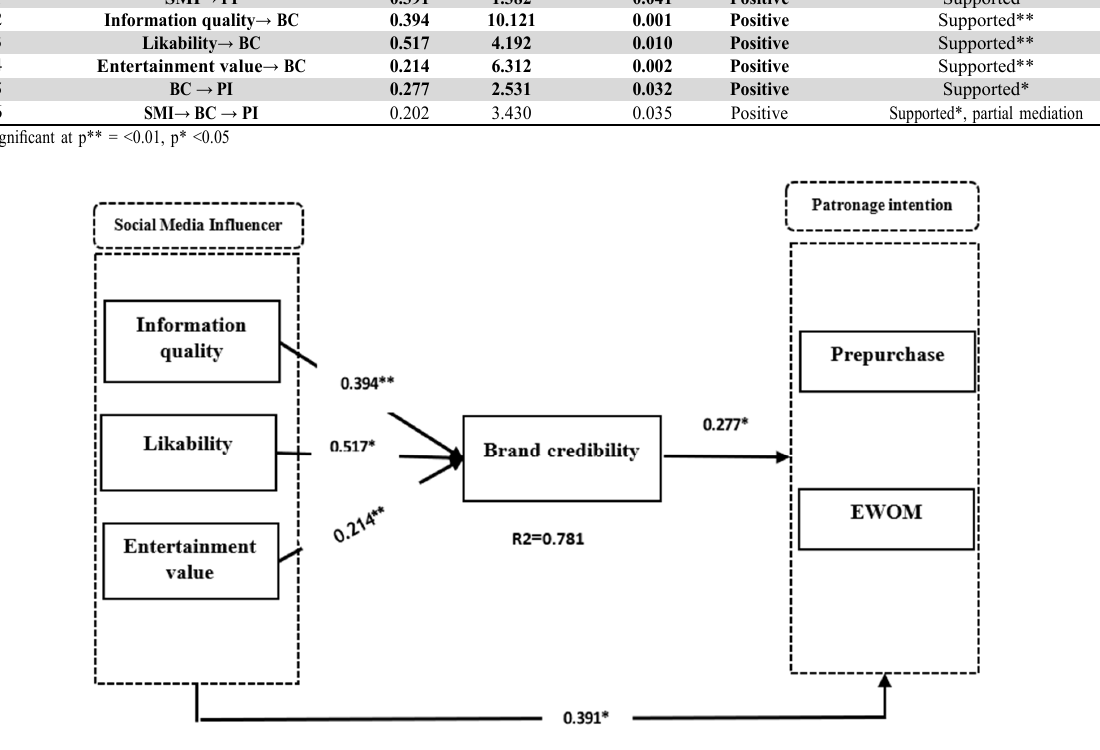
Fig. 2. Path coe ffi cient results (Signi fi cant at p** ≤ 0.01, p*